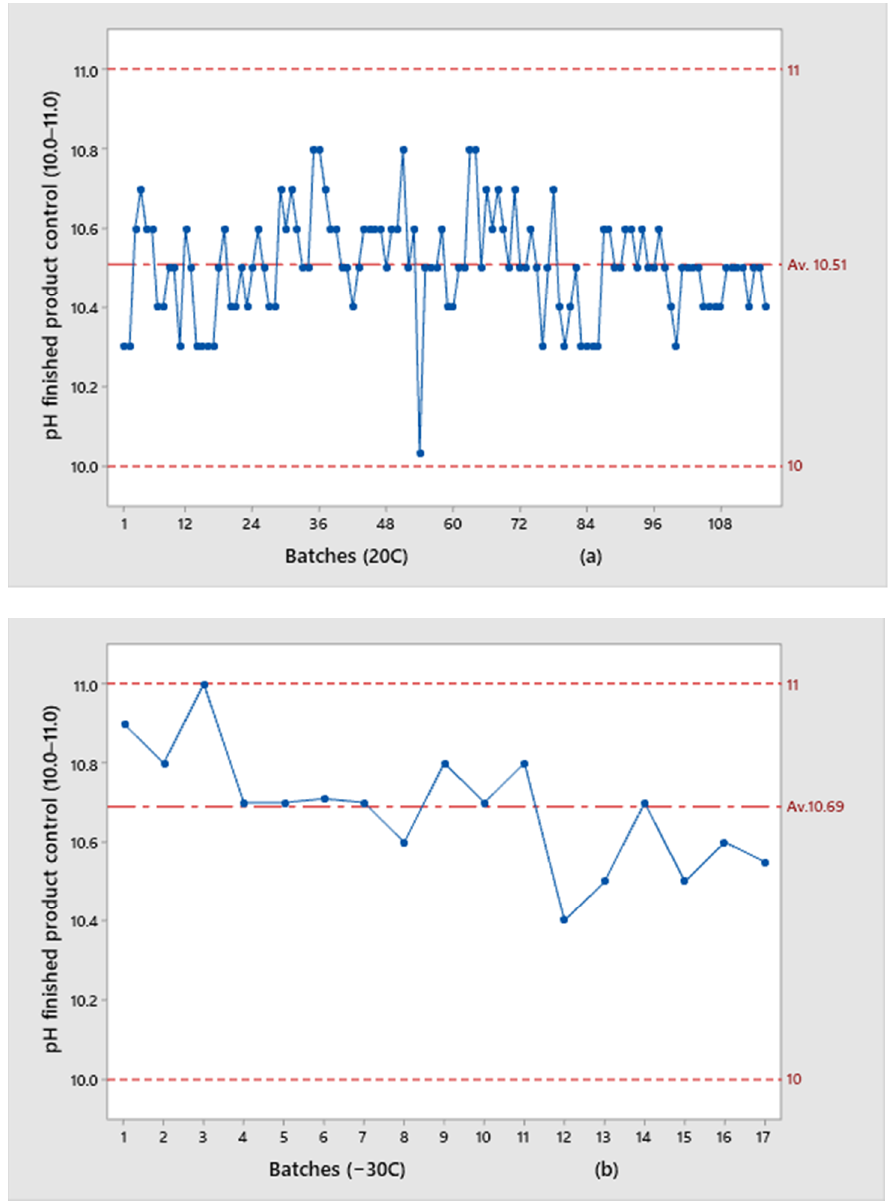
Figure 4. Comparison of pH values of the finished product for the batches: ( a ) kept at 20 °C; ( b ) kept at −30 °C.